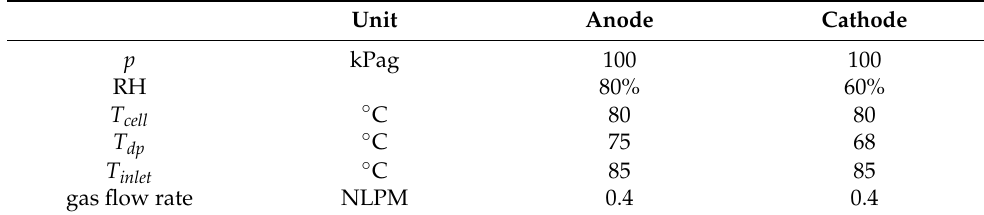
Table 1. Operating